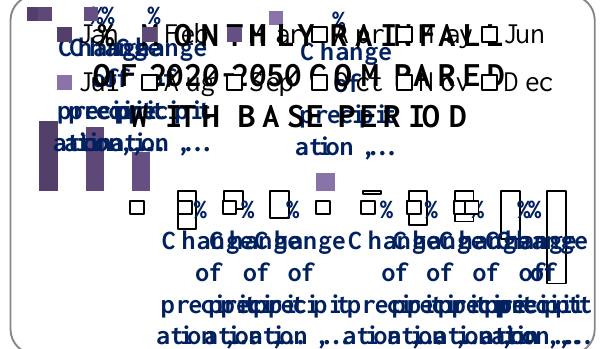
Figure 9. Precentage monthly rainfall of 2020-2050 compared with base period